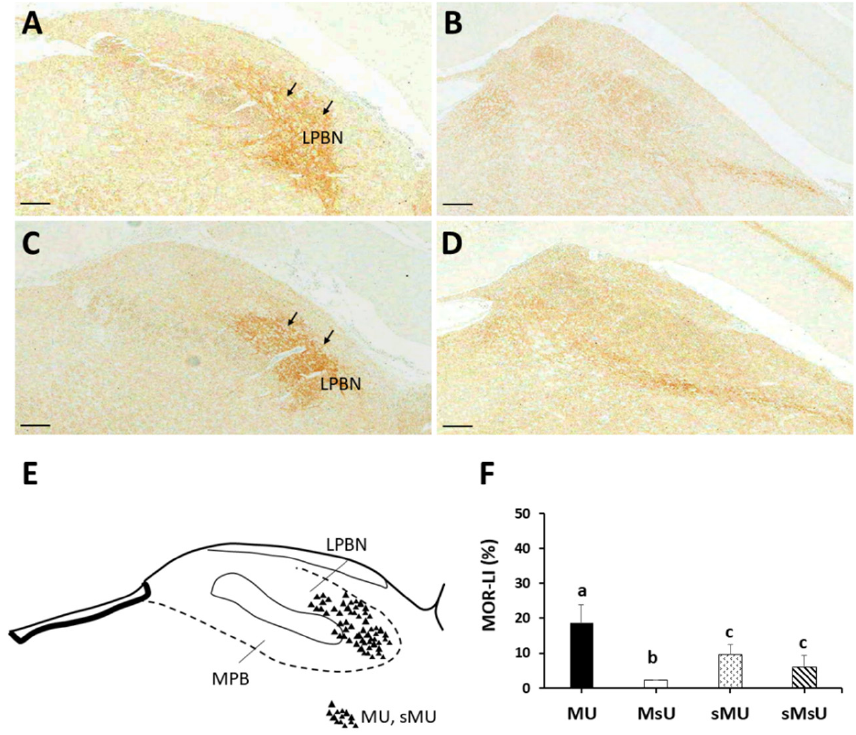
Figure 4. Representative MOR-LI staining in sections of lateral parabrachial nucleus (LPBN) in rats of MU ( A ), MsU ( B ), sMU ( C ), and sMsU ( D ) groups. The distributions of MOR-LI staining area are mostly located in LPBN in MU and sMU groups (triangles, E ). Data of MOR-LI in LPBN are presented mean ± SD and values with different superscripts (e.g., a vs. b and b vs. c) indicate significant differences ( p < 0.0083) for all possible pairwise comparisons of means tested by Mann–Whitney tests ( F ). Scale bars, 250 µ